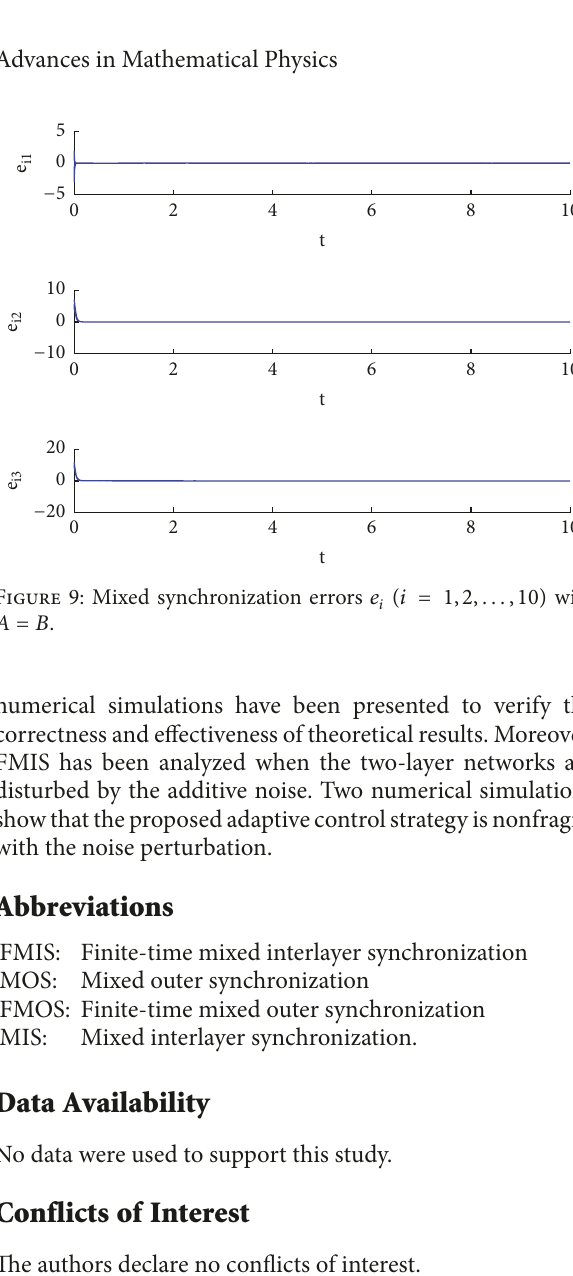
numerical simulations have been presented to verify the correctness and effectiveness of theoretical results. Moreover, FMIS has been analyzed when the two-layer networks are disturbed by the additive noise. Two numerical simulations show that the proposed adaptive control strategy is nonfragile with the noise